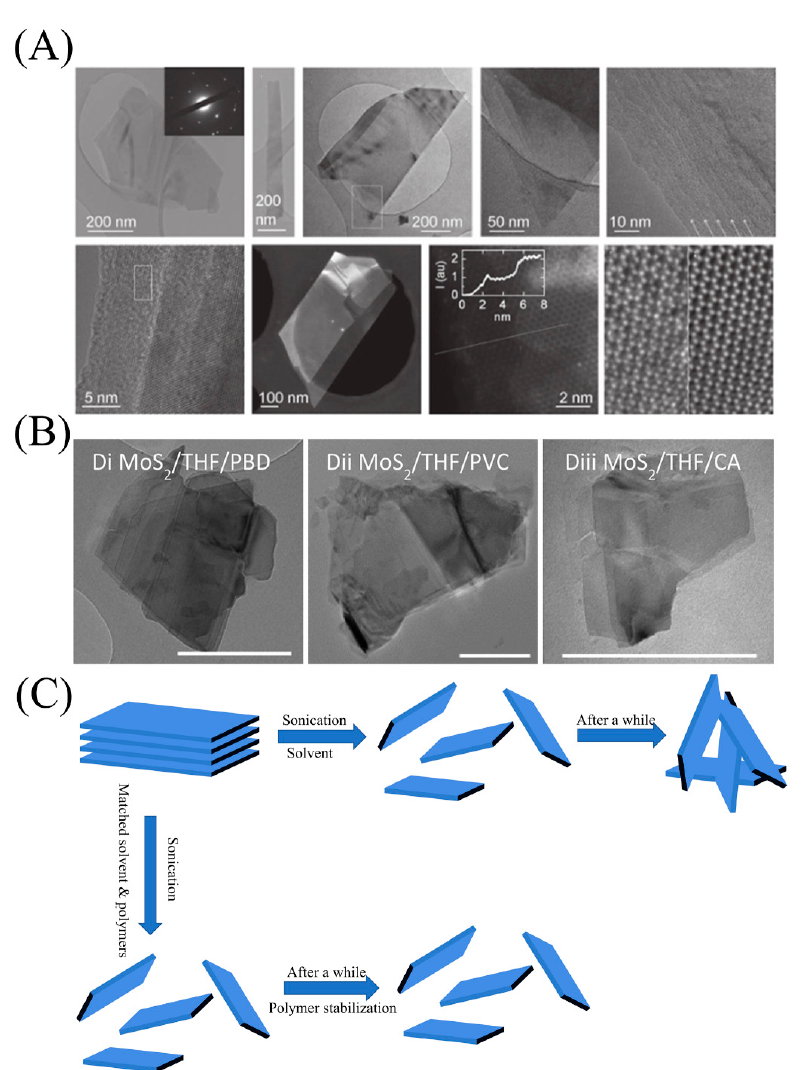
Figure 3. ( A ) Transmission electron microscope (TEM), high-resolution TEM (HRTEM) and high angle annular dark field scanning transmission electron microscope (HAADF STEM) image of MoS 2 nanosheet exfoliation in sodium cholate solution. Reproduced with permission from [63] Copyright © 2021 WILEY-VCH. ( B ) TEM images of nanosheets dispersed in polymer/solvent solutions. Each image is labeled using the following convention: nanosheet/solvent/polymer. Reproduced with permission from [64] Copyright © 2021 American Chemical Society. ( C ) Schematic diagram of polymer